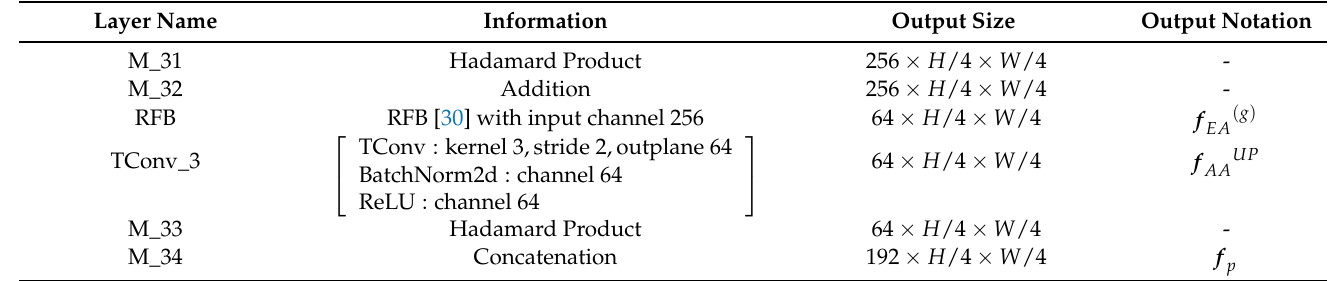
Table 3. Detailed layer information and feature maps size in Figure 3. The size of input image S I is 3 × H × W , and the size of output S p is n × H × W